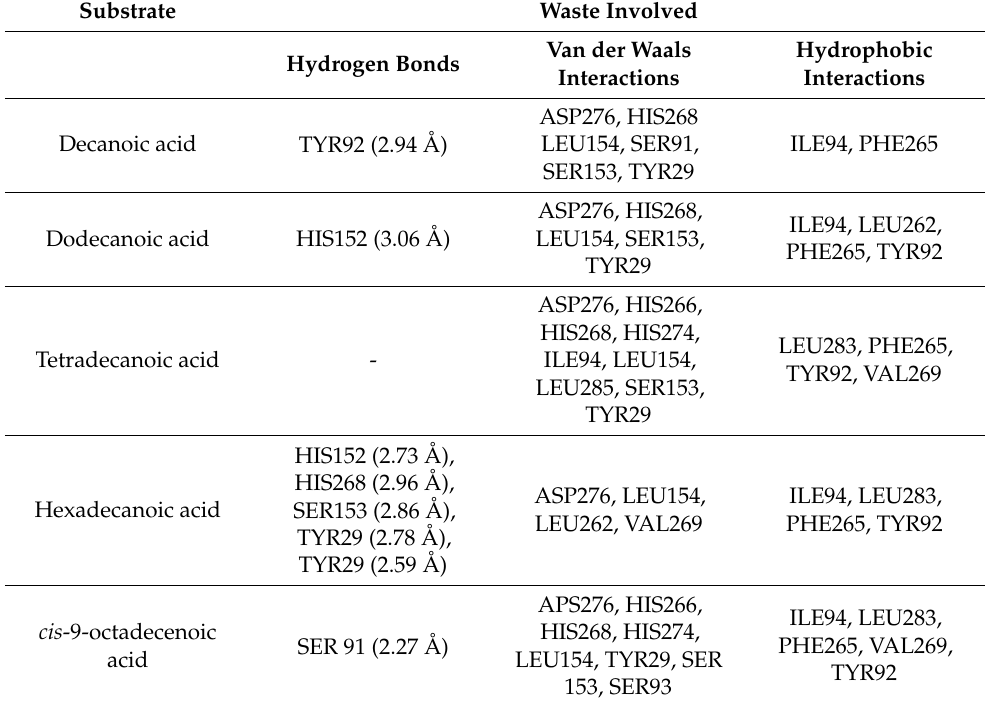
Table 5. Cont. Substrate Waste